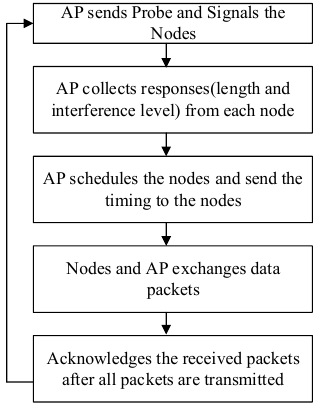
Figure 3. Janus, A Centralized FD-MAC